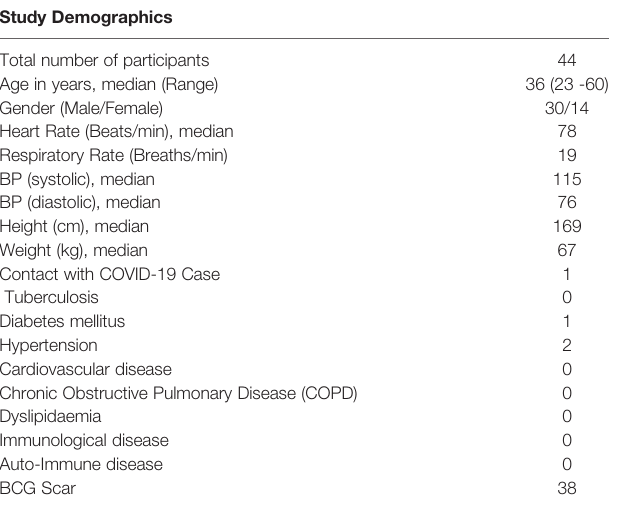
TABLE 1 | Characteristics of the study